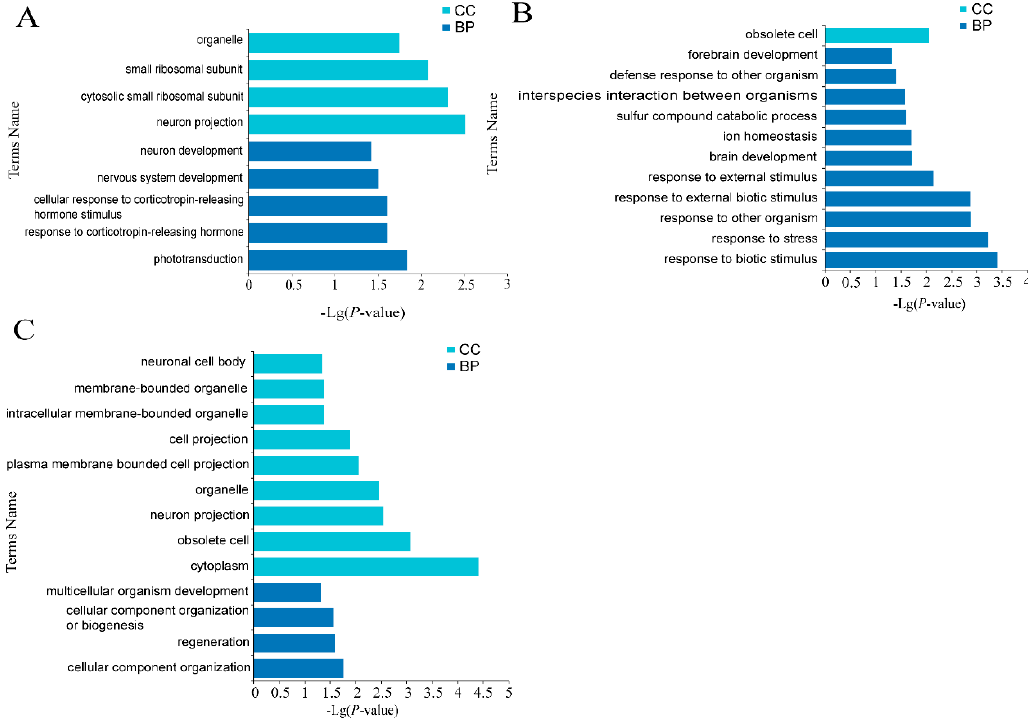
Figure 5. Enrichment analysis of pituitary mRNAs. ( A ) Enriched GO terms of luteal phase, ( B ) Enriched GO terms of proestrus, ( C ) Enriched GO terms of estrus. Dark blue represents BP, light blue represents CC, and orange indicated MF.